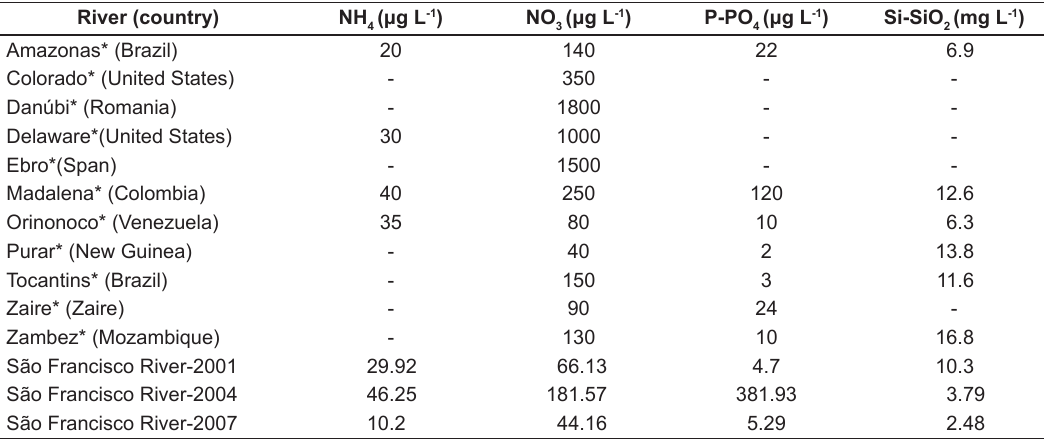
Table 5. Annual mean concentration of inorganic dissolved nutrients during the three hydrological year and com- parison with the values from other tropical rivers (*from Meybeck & Ragu, 1996). River (country)